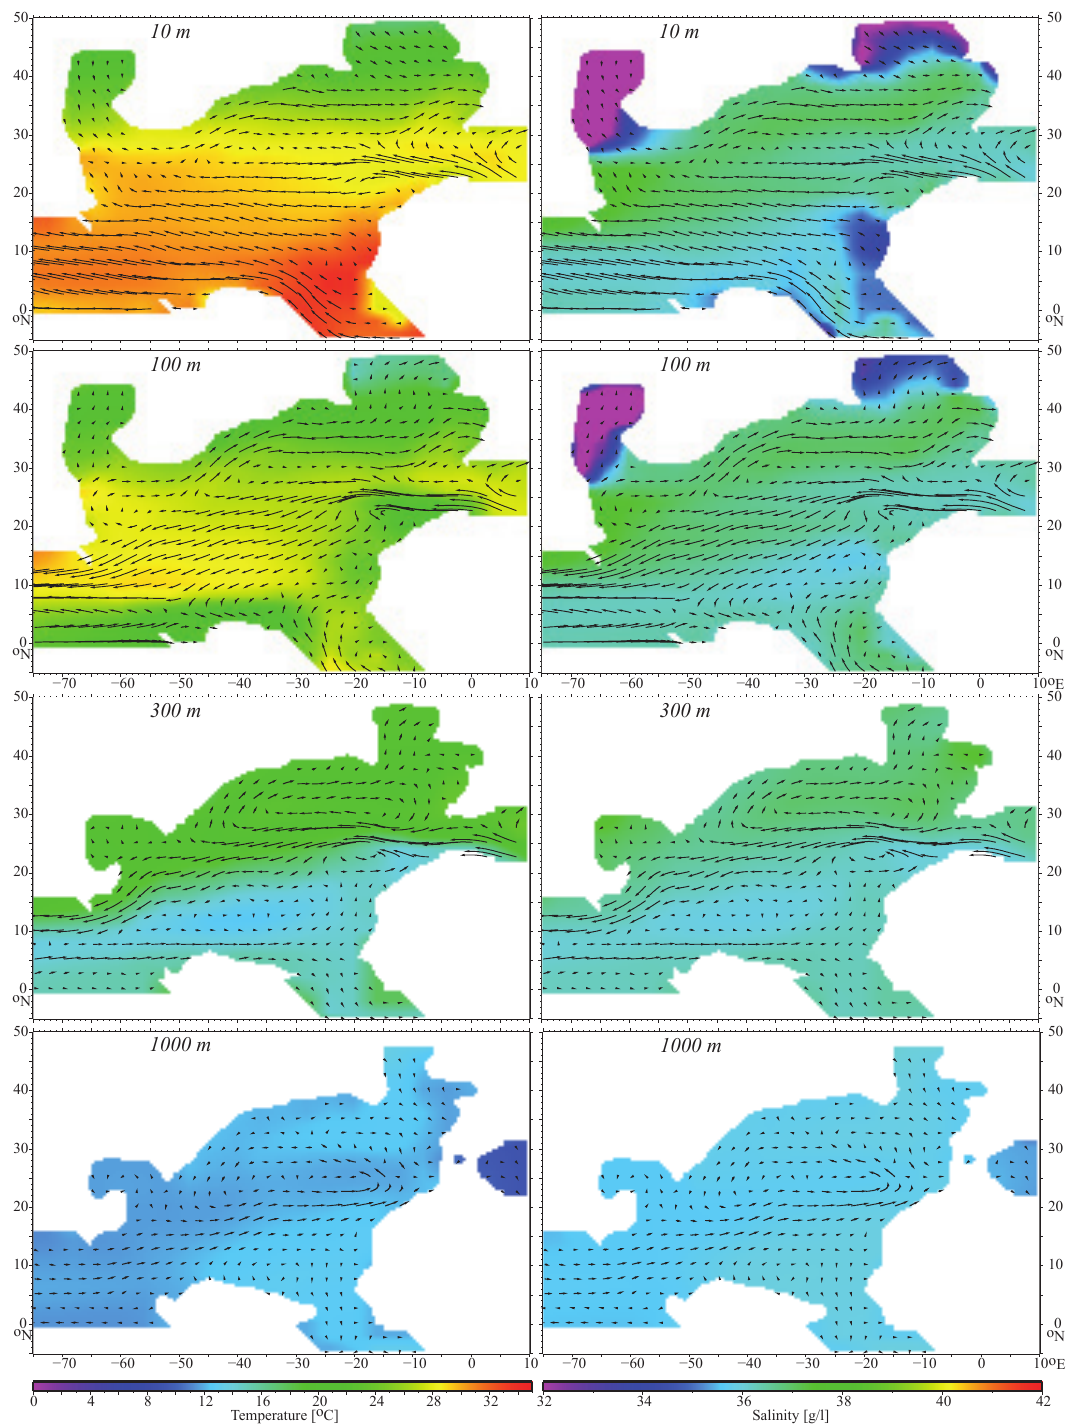
Fig. 2. Initial conditions. The temperature (left column) and salinity (right column) from the CCSM3 results at the surface and depths of 100, 300 and 1000m going from top to bottom. Lines show the paths water particles would travel in 30, 54, 84 and 114 days (particle trace time increasing with depth) keeping the average mean velocity field from the same CCSM3 results constant. For clarity, only every fifth grid point is followed . The temperature and salinity shown here are used to set the initial density field in the model, and the value to which relaxation takes places in the sponges, and are used for comparison with regional model